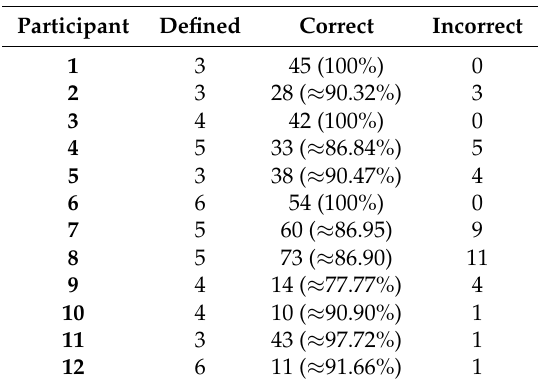
Table 2. Results from the accuracy